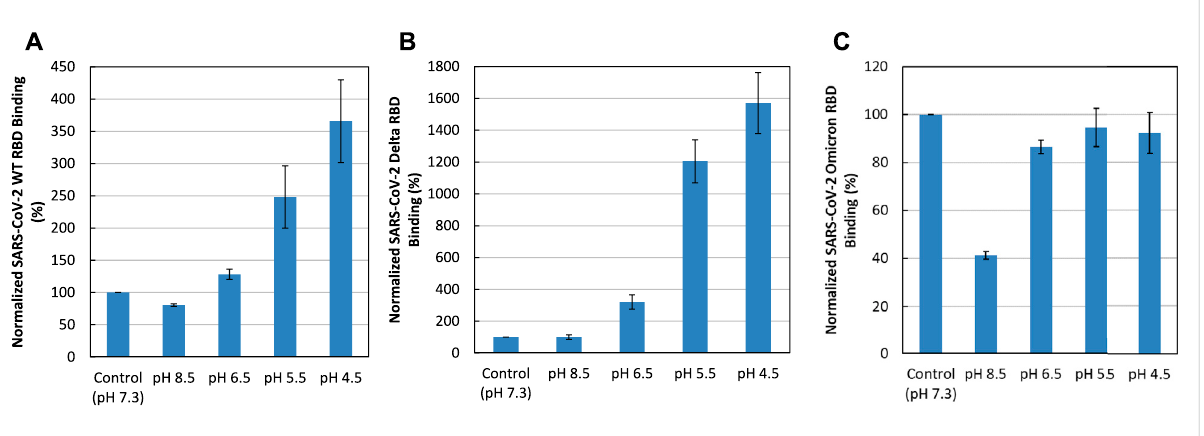
FIGURE 7 Effect of pH on the interaction of SGP-RBD interaction with heparin. Bar graphs (based on triplicate experiments with standard deviation) of normalized SGP-RBD binding to surface heparin at different pH levels (A) WT; (B) Delta; (C)